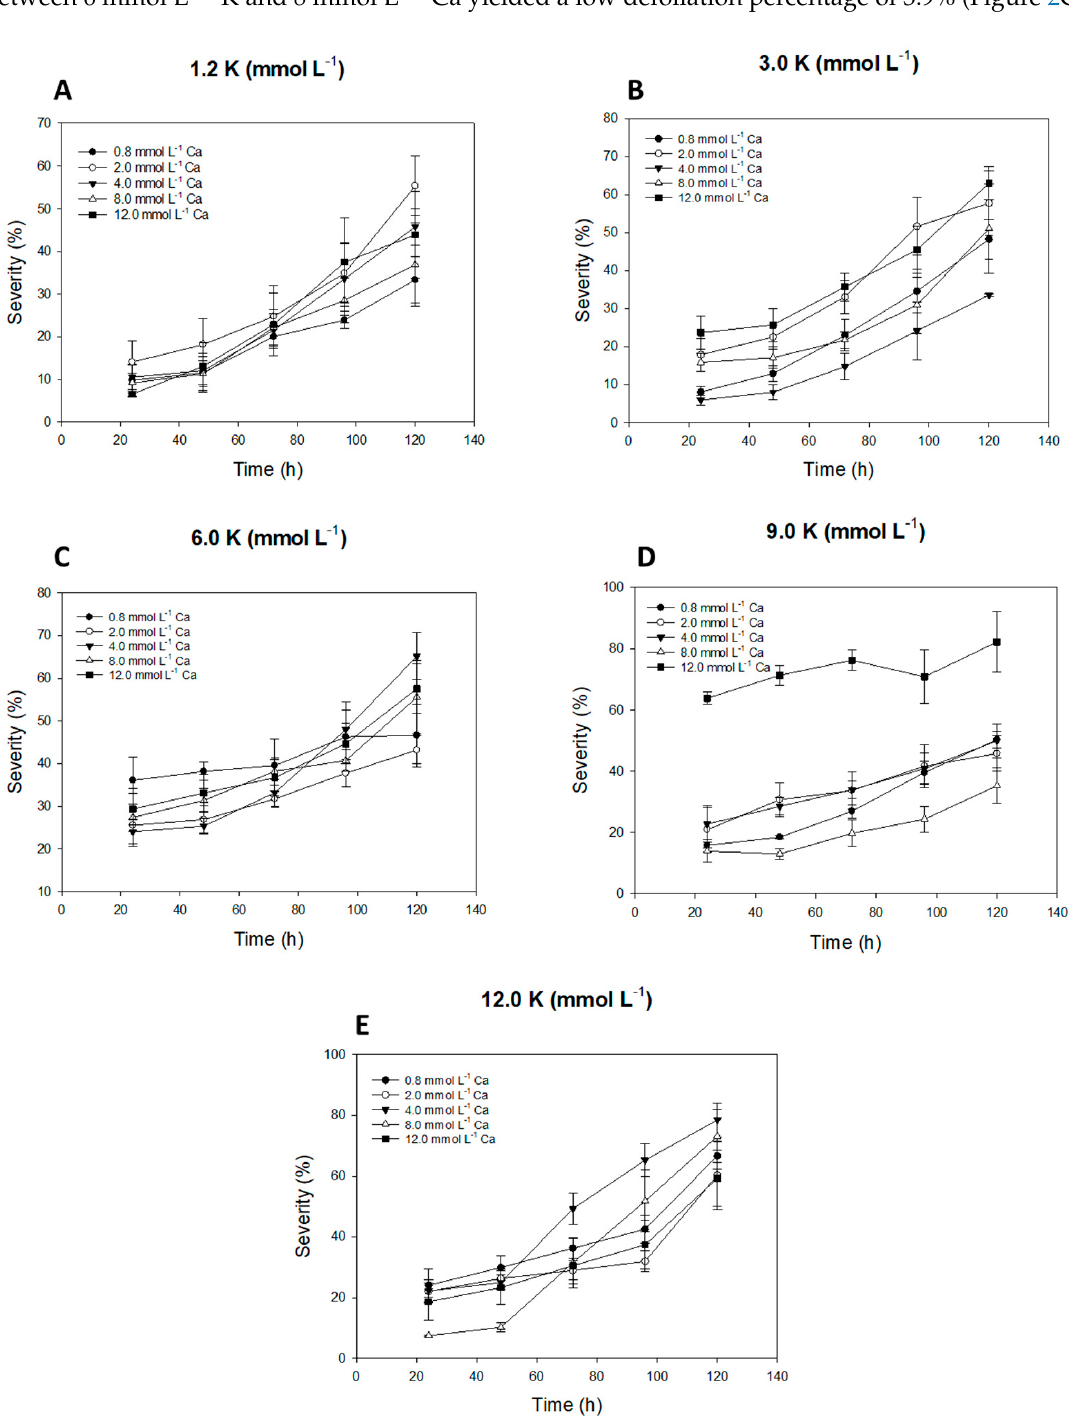
Figure 1. Severity (%) of Calonectria leaf blight in eucalyptus over time in the presence of different doses of Ca (mmol L − 1 ) combined with ( A ) 1.2 mmol L − 1 , ( B ) 3.0 mmol L − 1 , ( C ) 6.0 mmol L − 1 , ( D ) 9.0 mmol L − 1 and ( E ) 12.0 mmol L − 1 K. The bars represent the standard error.